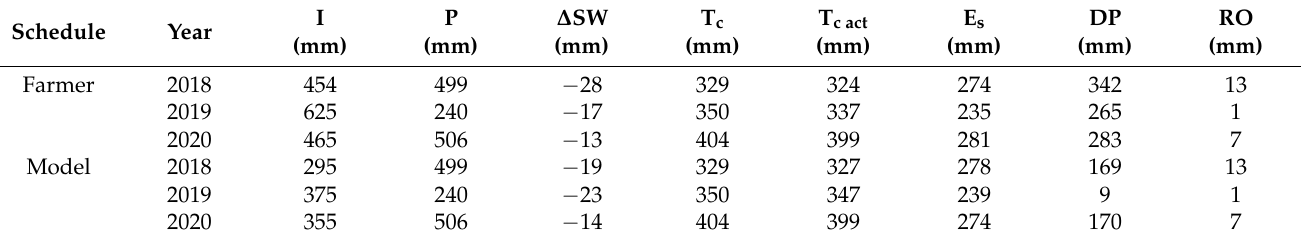
Figure 7. Seasonal evolution of the potential non-stressed basal crop coefficients (K cb ), the actual basal crop coefficients (K cb act ), the soil evaporation coefficients (K e ), and the actual crop coefficients (K c act = K cb act + K e ) computed by SIMDualKc for the Samora Correia vineyard during the 2018–2020. Table 10. Components of the soil water balance in the Samora Correia vineyard.